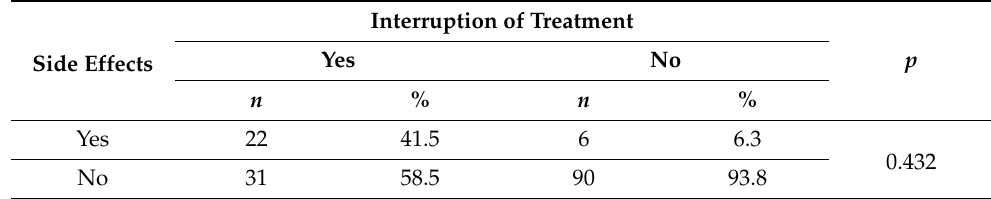
Table 5. Correlation between side effects and interruption of